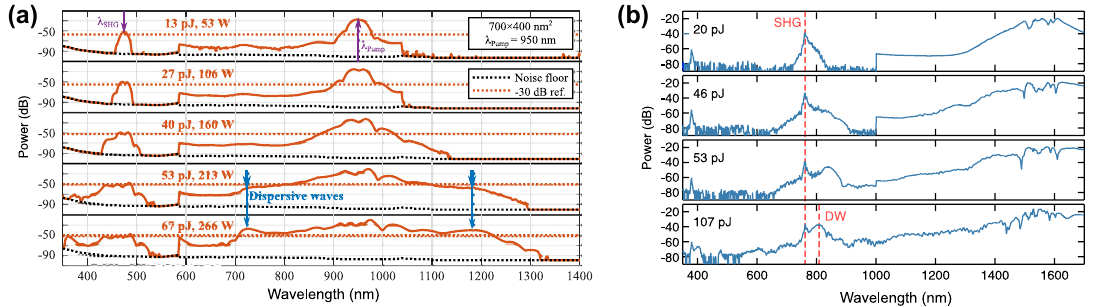
Figure 16: Evolution of SCG in LNOI waveguides for different pulse energies. (a) A waveguide with a top width of 700 nm and a height of 400 nm pumped at 950 nm. (b) A waveguide with a top width of 1250 nm and a height of 800 nm pumped at around 1560 nm. Panels (b) and (a) adapted from [129, 130]